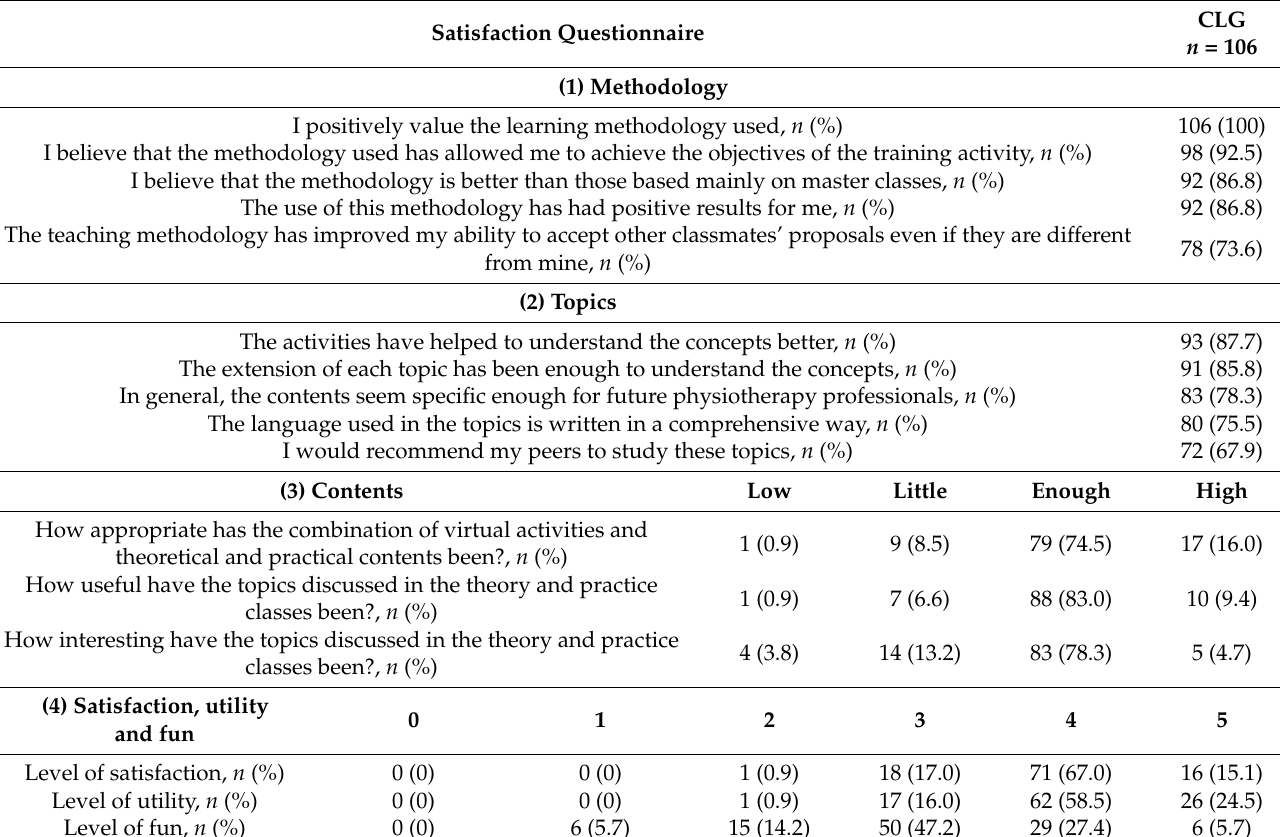
Table 4. Answers of the satisfaction questionnaire at the end of the program for the cooperative learning